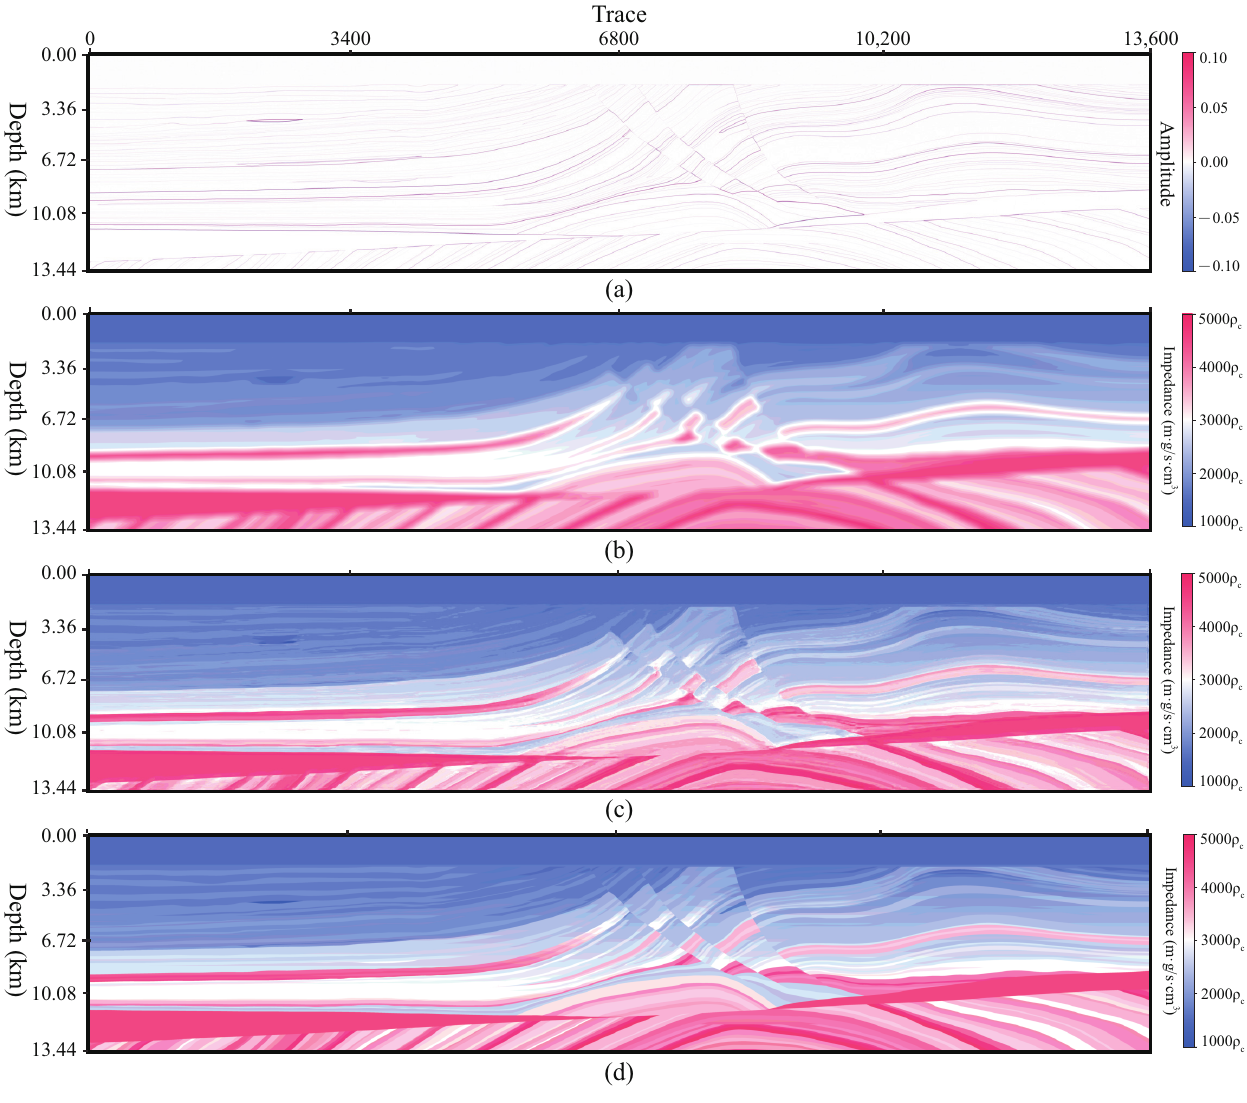
Figure 12. Test result of the Marmousi profile, ( a ) M , K = 0.034, SNR = 5.00 dB, P = − 9 ◦ , channel 1 of input data, ( b ) B , channel 2 of input data, ( c ) predicted profile ˆZ , PCC = 0.9813, R 2 = 0.7994, SSIM = 0.9081, PSNR = 23.96 dB. ( d ) label profile Z